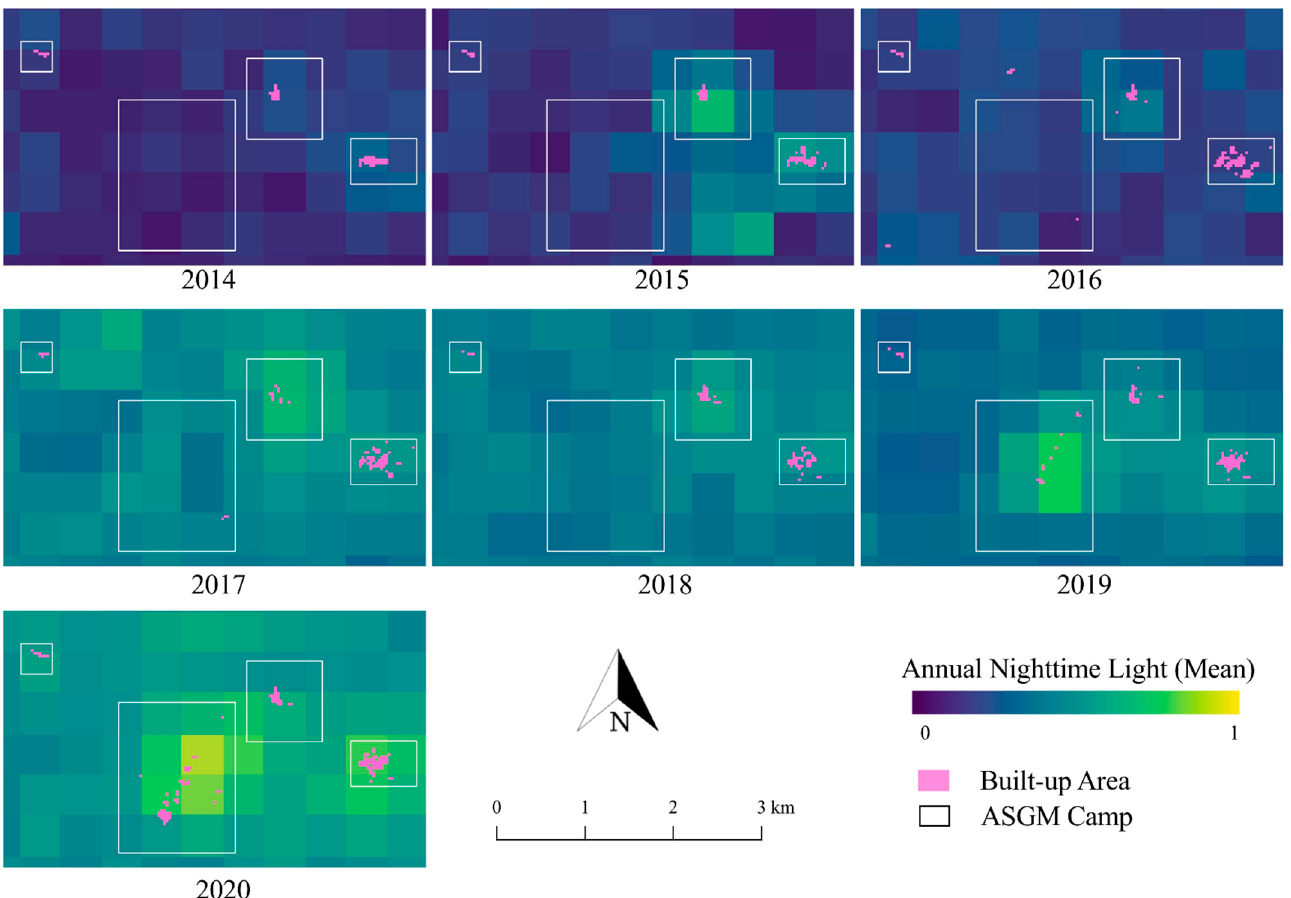
Figure 3. Overlay of built-up areas on annual mean NTL images in time-series.